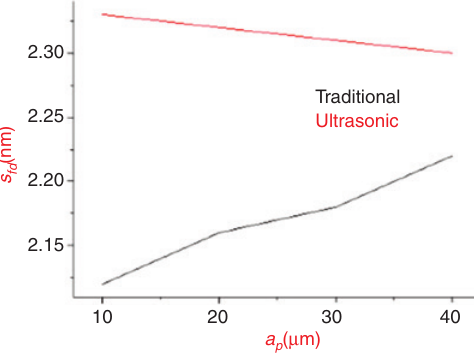
: traditional vs. ultrasonic. Figure 12: Surface S fd